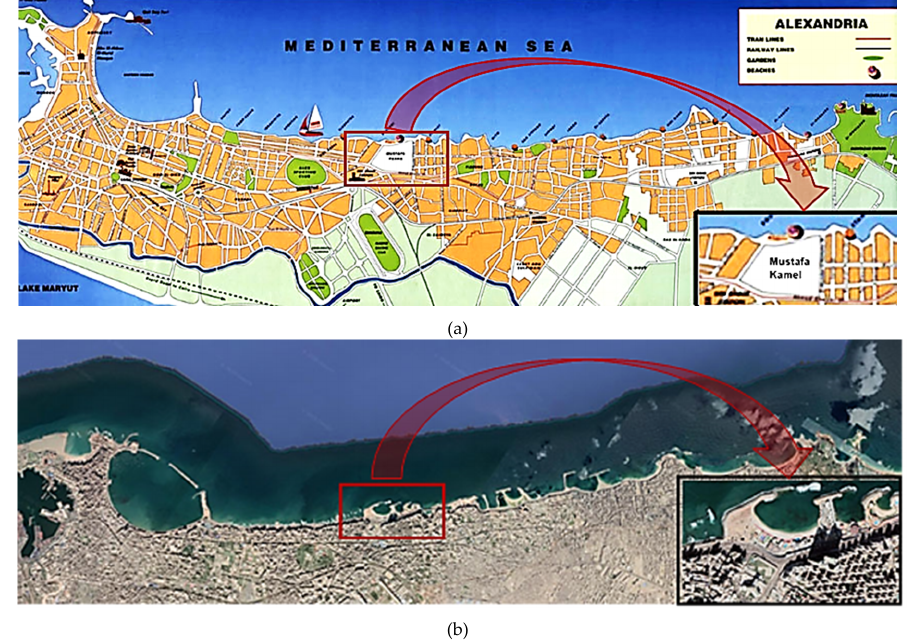
Figure 1. ( a ) Alexandria’s map with ‘Mustafa Kamel’ district enlarged. Source: [46]. ( b ) Alexandria’s Figure 1. (a) Alexandria’s map with ‘Mustafa Kamel’ district enlarged. Source: [46]. (b) Alexandria’s Google Google Earth map with ‘Mustafa Kamel’ district enlarged. Source: Google Earth. Earth map with ‘Mustafa Kamel’ district enlarged. Source: Google Earth